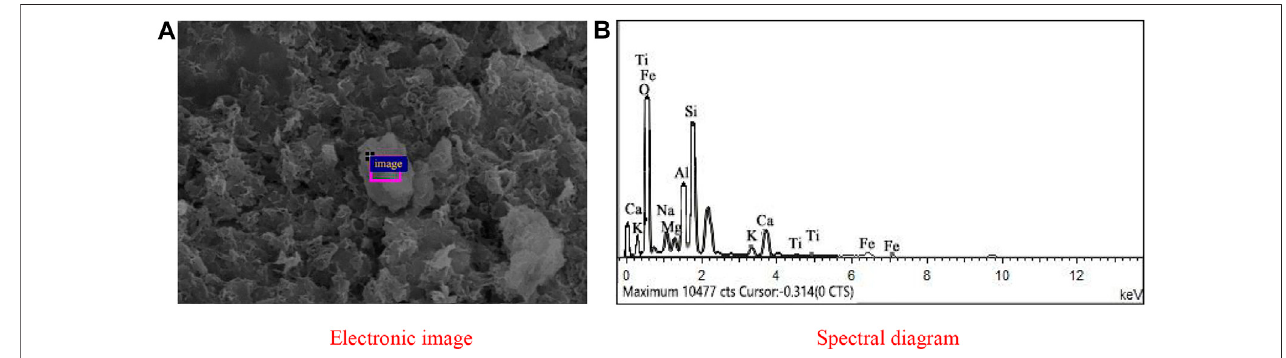
FIGURE14| EDSofFAfromtheselectedareainthesamplewith80%GGBFSand20%FAat6.50 mol/LNHsolution: (A) Electronicimage; (B) Spectral diagram.